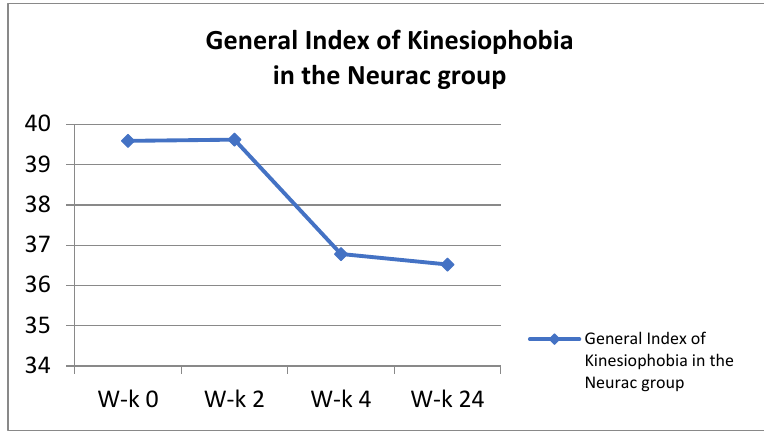
Figure 4. General Index of Kinesiophobia in the Neurac group.